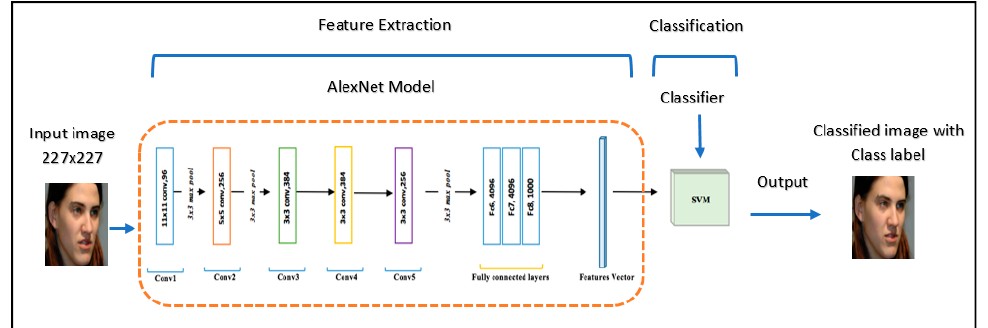
Figure 4. AlexNet convolutional neural networks with SVM.